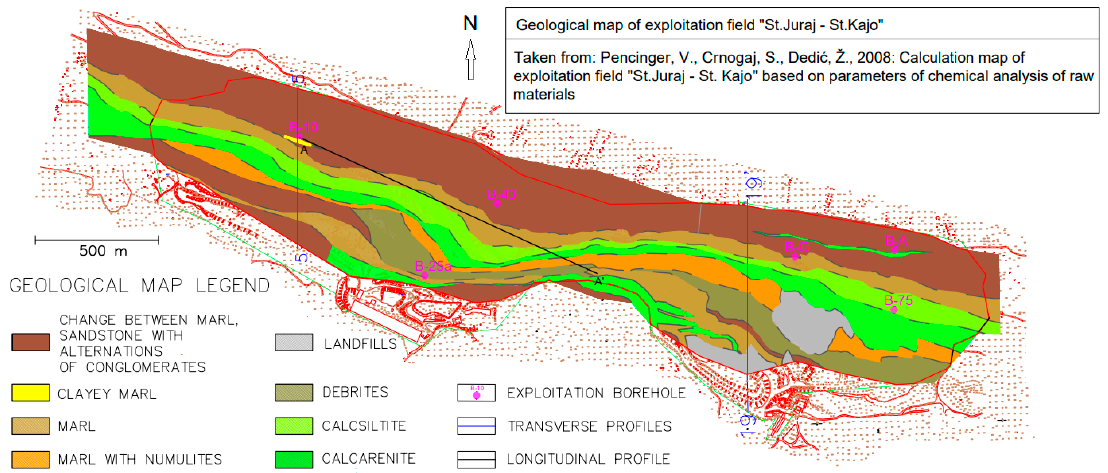
Figure 2. Geological map of the field of exploitation “St. Juraj–St. Kajo” (modified according to [20]).